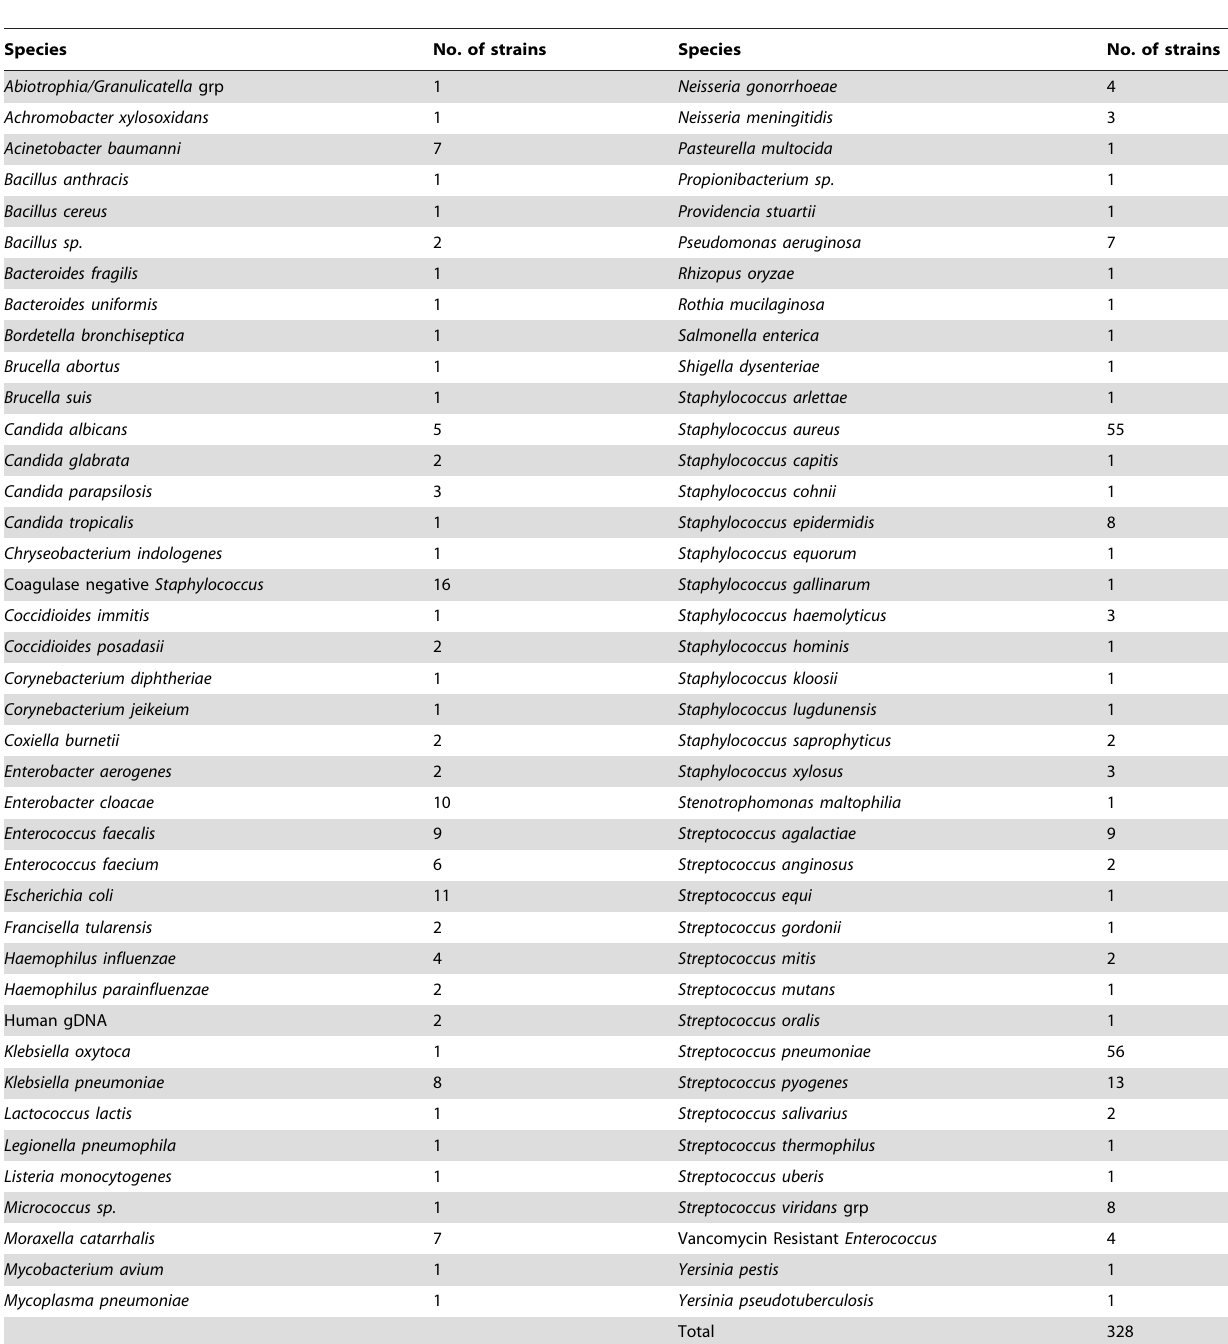
Table 2. Species and number of differential diagnostic and background flora strains screened across BurkDiff to validate the assay’s